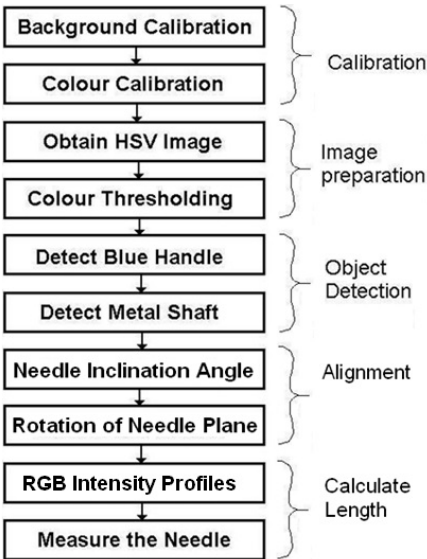
Figure 4. Implemented image processing